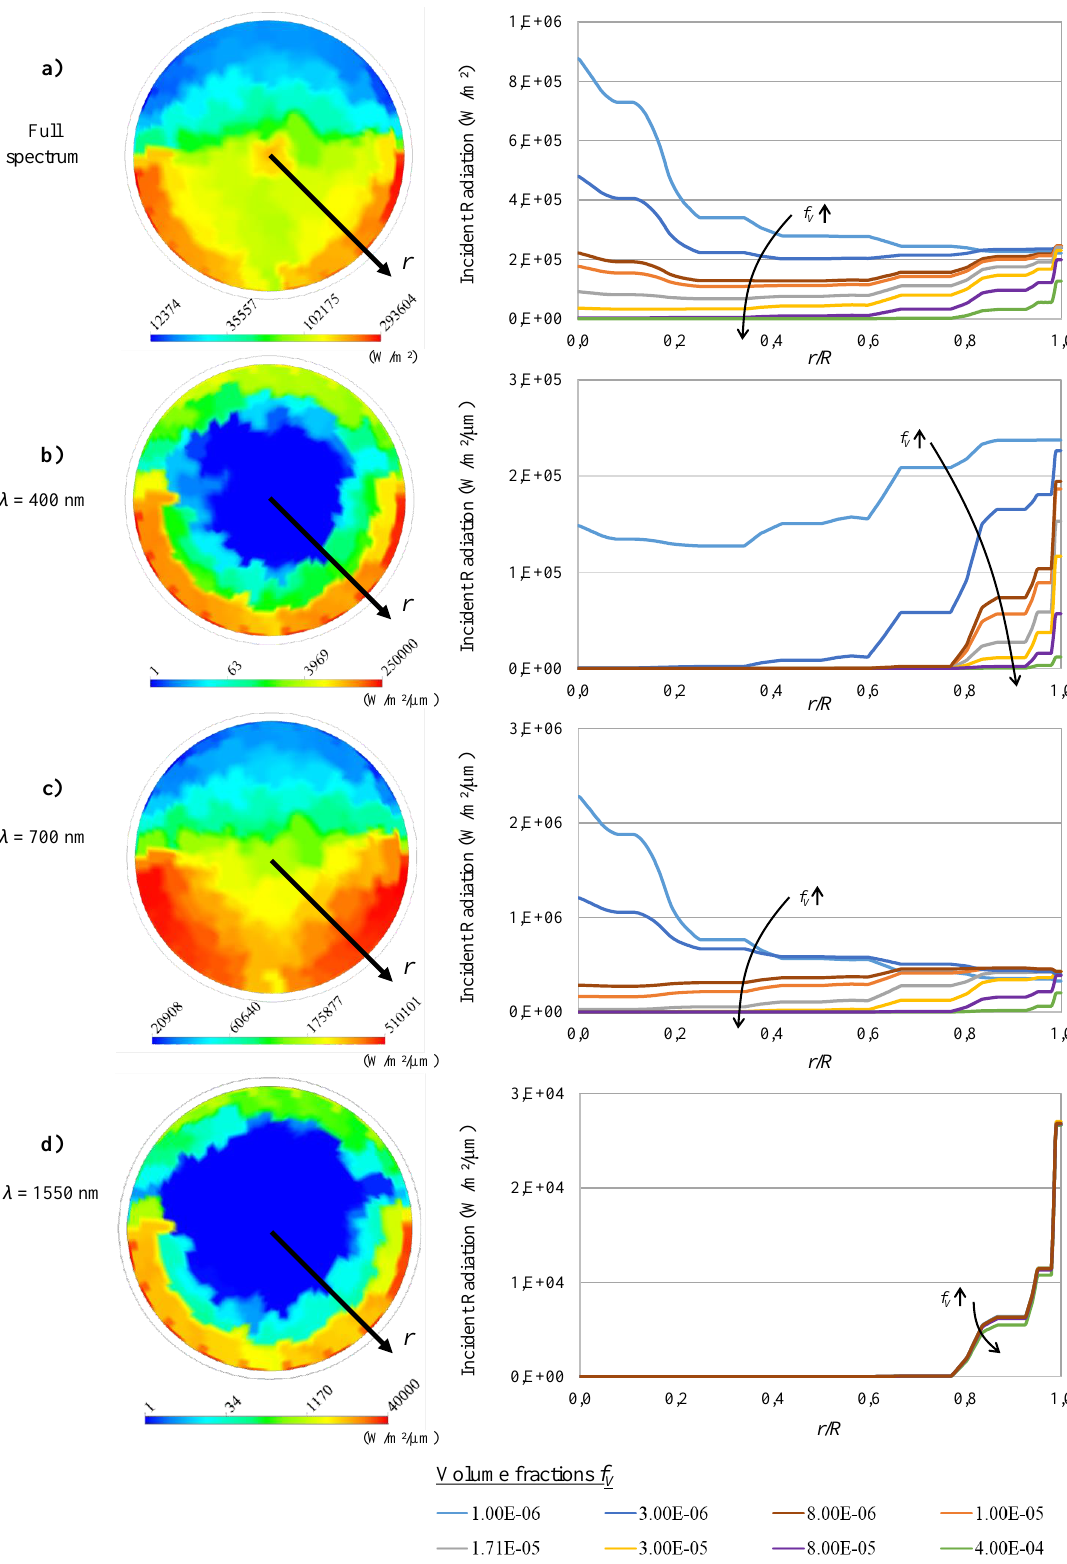
Figure 2. Distribution of radiation intensity in the absorber cross-sectional area for: ( a ) the solar spectrum; ( b ) λ = 400 nm; ( c ) λ = 700 nm; and ( d ) λ = 1550 nm for different particle volume fractions f V